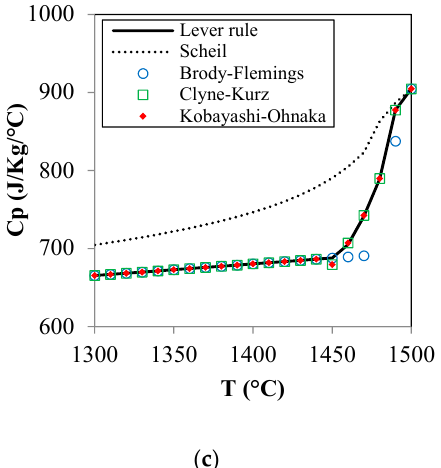
Figure 6. Temperature dependence of specific heat for the steel in study according to different microsegregation solidification models for the case: ( a ) α = 10.57 (ingot wall side); ( b ) α = 12.60 (mid-radius region); ( c ) α = 12.66 (ingot center).